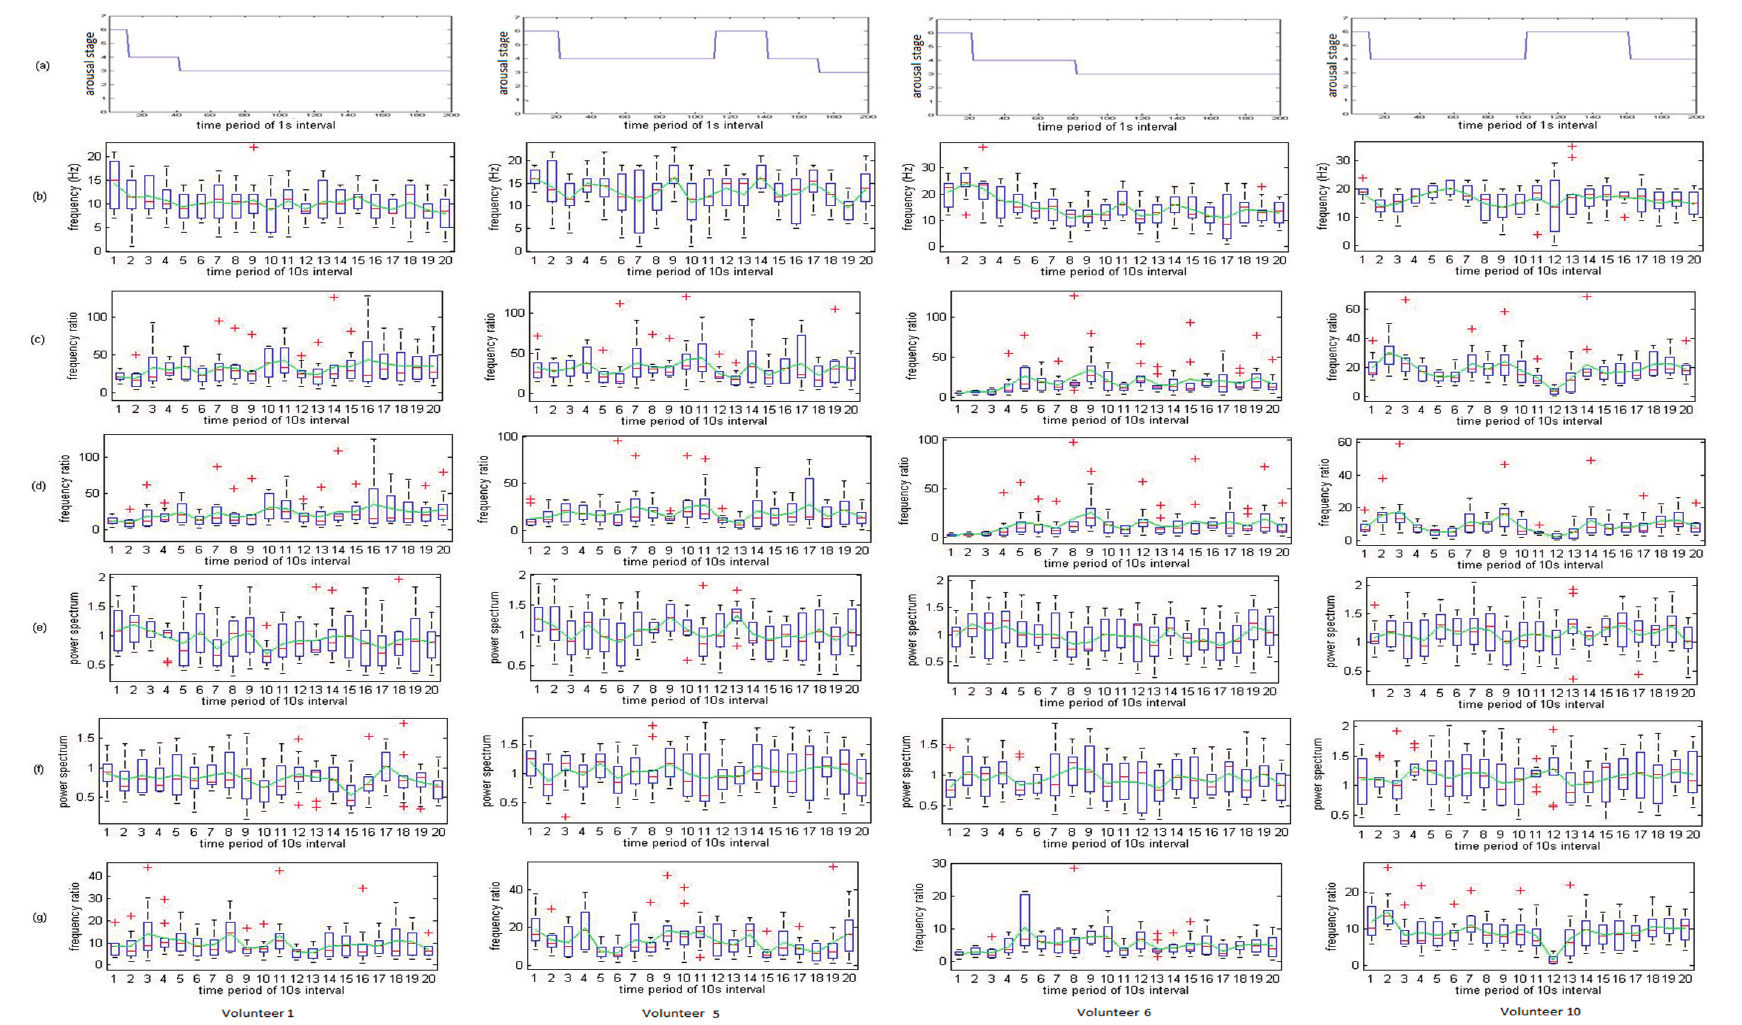
Figure 5. Arousal stage for four different volunteers for the top six most descriptive derived from MI (shown in Table 4) with ( a ) arousal stage with 1 s interval; ( b ) ABSDELTA EEG2; ( c ) TAABRATIO EEG2; ( d ) TABRATIO EEG2; ( e ) FVBETA EEG2; ( f ) FVBETA EEG1; and ( g ) TBRATIO EEG2 with 10 s interval